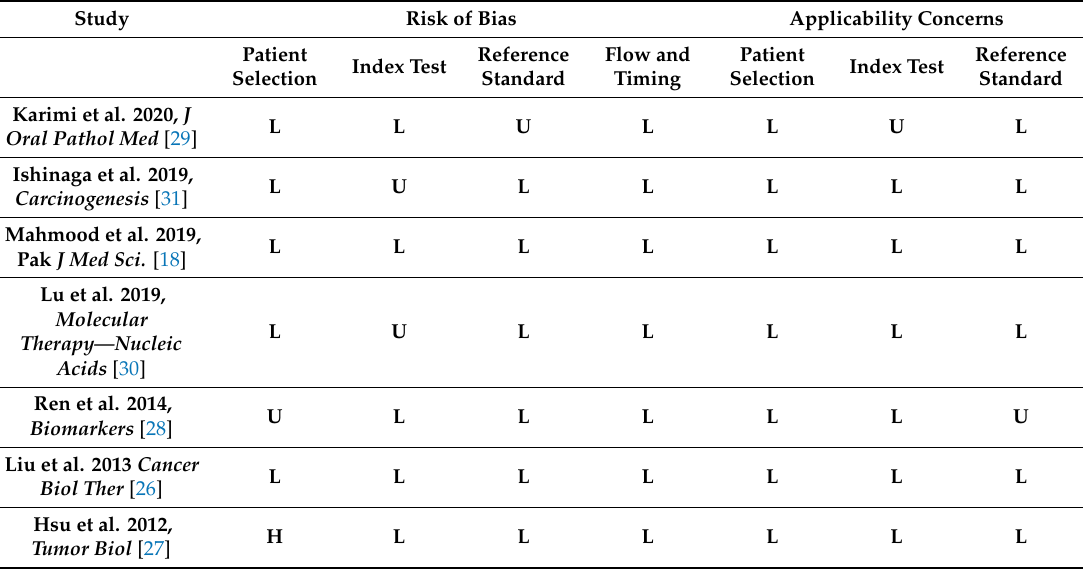
Table 4. Quality Assessment of Diagnostic Accuracy Studies 2